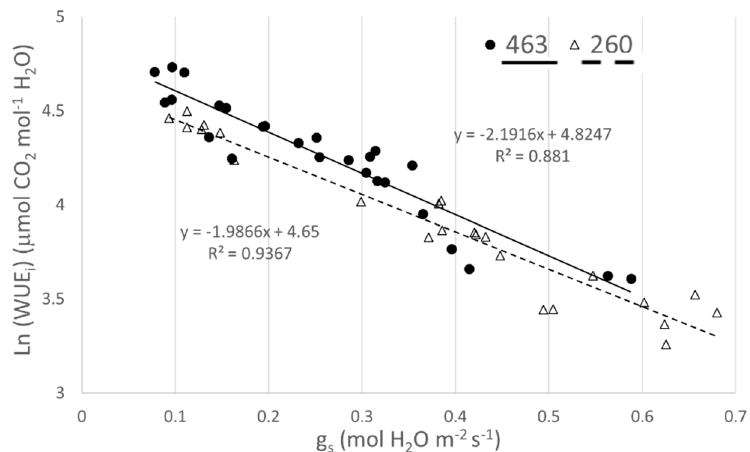
Figure 2. Relationship between the natural logarithm of the WUE i against g s , all years confounded, in the two more contrasting genotypes.